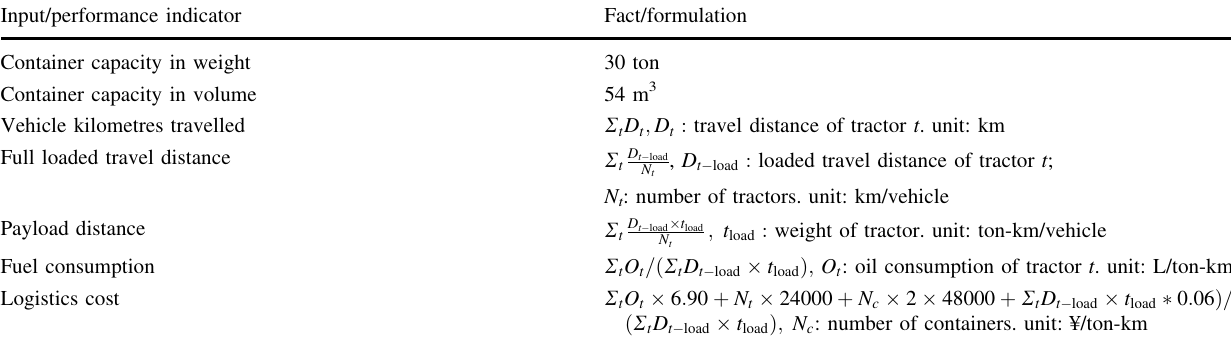
Table 2 Input and performance indicators (Note: constants correspond to the practical setting of the investigated system) Input/performance